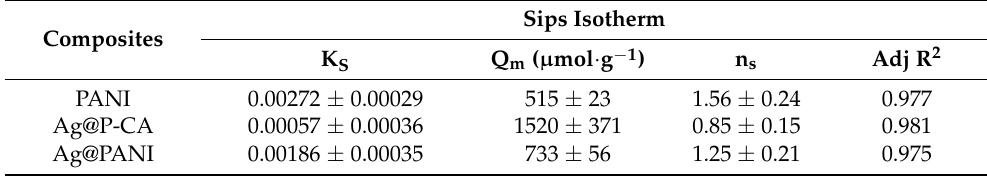
Table 2. Best-fit isotherm parameters for the Sips model in a PBS-7 buffer solution at 295 K.